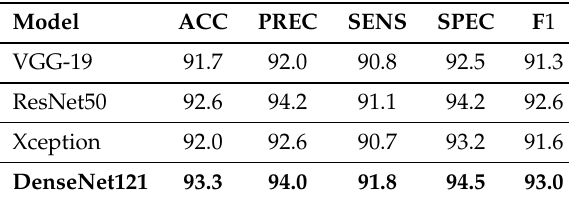
Figure 14. Heat maps visualising response of the last layer of VGG-19 model, superimposed on input images. Table 2. Model performance [%].